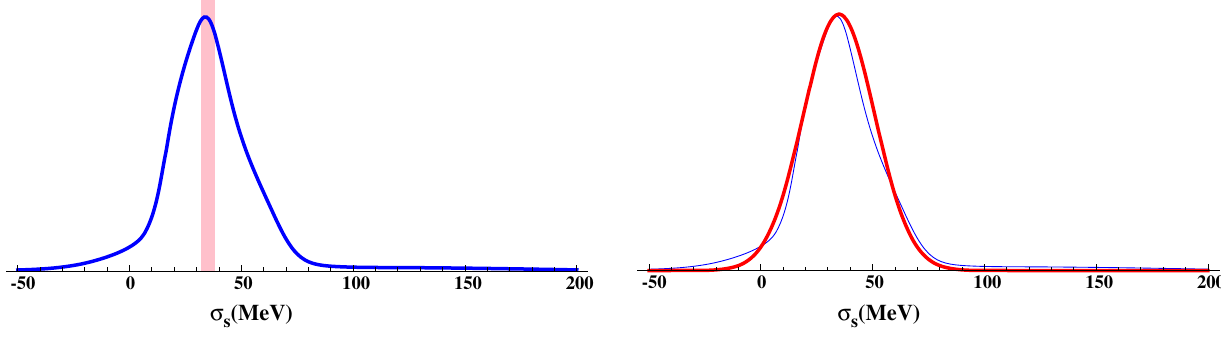
Fig. 4 Left panel: Ideogram combining all values of σ s . Right panel: Ideogram combining all values of σ s compared with a Gaussian centred at σ = 35 MeV with width σ = 16 s